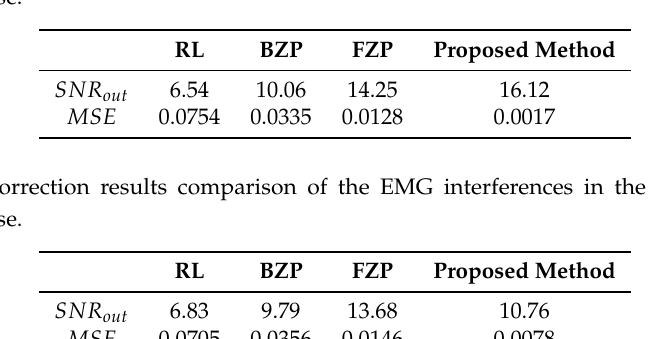
Table 4. The correction results comparison of the power line interferences in the signal 115 of the MIT-BIH database.